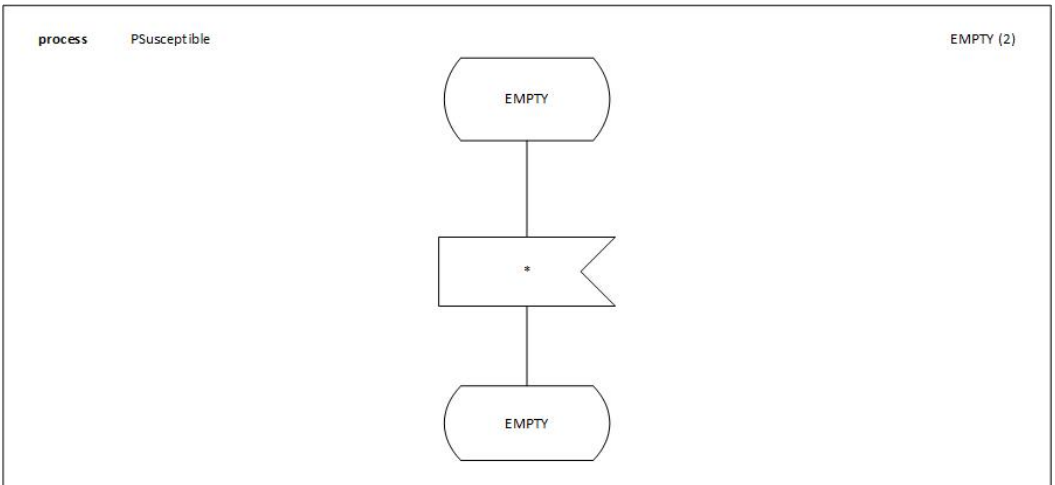
Figure 8. PSusceptible EMPTY state. No more susceptible individuals exist, hence the model finishes Figure8. PSusceptible EMPTYstate. Nomoresusceptibleindividualsexist, hencethemodelfinisheshere. here.